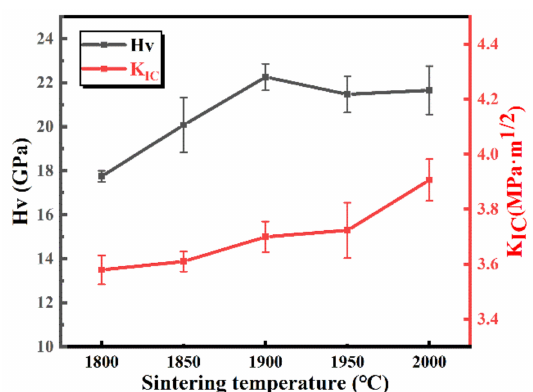
Figure 7. The hardness and fracture toughness of the sintered SiC samples with 9 wt.% Y 2 O 3 -Er 2 O 3 as a function of the sintering